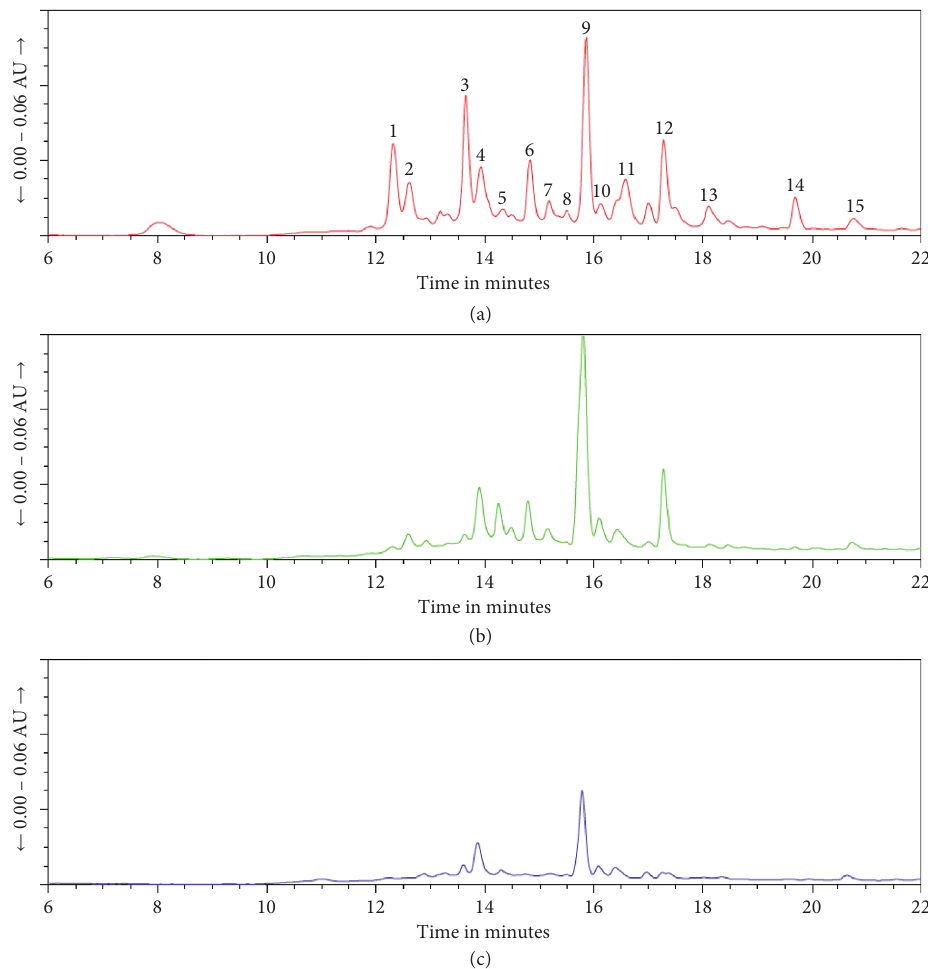
Figure 4: Changes in HPLC patterns of white teff phenolic compounds (soluble fraction) due to mushroom mycelium-mediated solid-state fermentation. (a) Matched control (unfermented); (b) G . lucidum (KACC 42231); (c) P . ostreatus (KACC